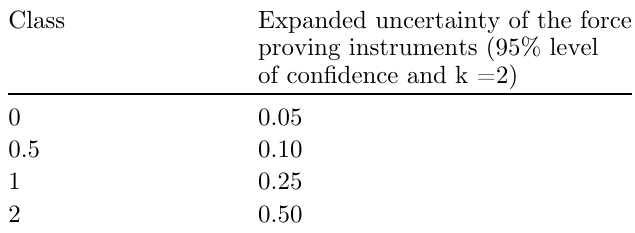
Table 4. The budget expanded uncertainty of the force